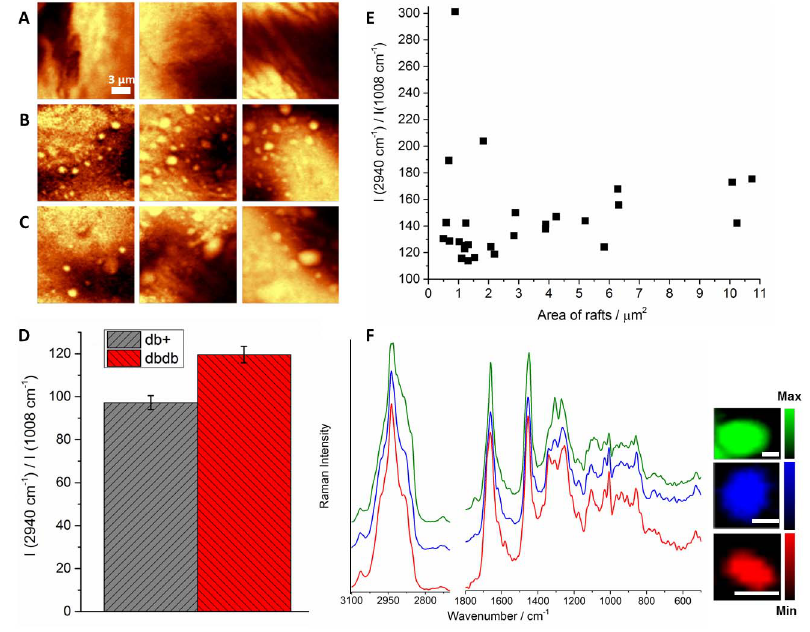
Figure 4. Clustering of lipid rafts in T2DM. Comparison of the representative Raman distribution images (integration over the band in the 2800– 3100 cm 2 1 range) of the en face endothelium of db + (control, A ), 16-weeks-old db/db ( B ) and 20-weeks-old db/db ( C ) mice. The overall endothelium lipid content (defined as the average intensity ratio of the band at 2940 to the band at 1008 cm 2 1 in all measured db/db or db + samples; D ). The individual lipid content of LRs (defined as the intensity ratio of the band at 2940 to the band at 1008 cm 2 1 for individual LR assemblies) as a function of their area ( E ). The correlation between the average spectra of representative LRs and their size (the scale bar denotes 1 m m, the spectra were normalized to the 1011 cm 2 1 band and offset in order to emphasize the differences between them, the Raman intensity in the 2700–3200 cm 2 1 range is 3-fold magnified relatively to the fingerprint region; F ).